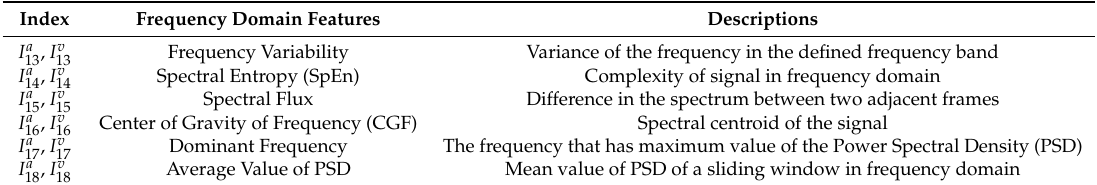
Table 2. Extracted frequency domain features from steering angle and velocity